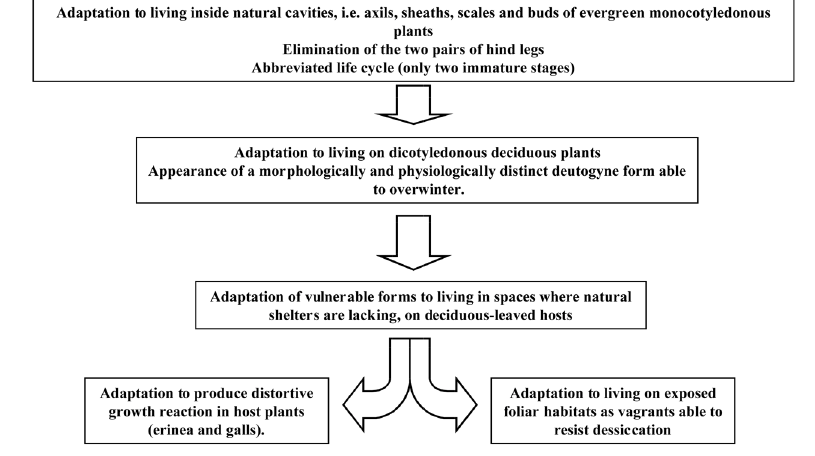
Fig. 8. Concise outline of the evolutionary trend of erio- phyid mites.